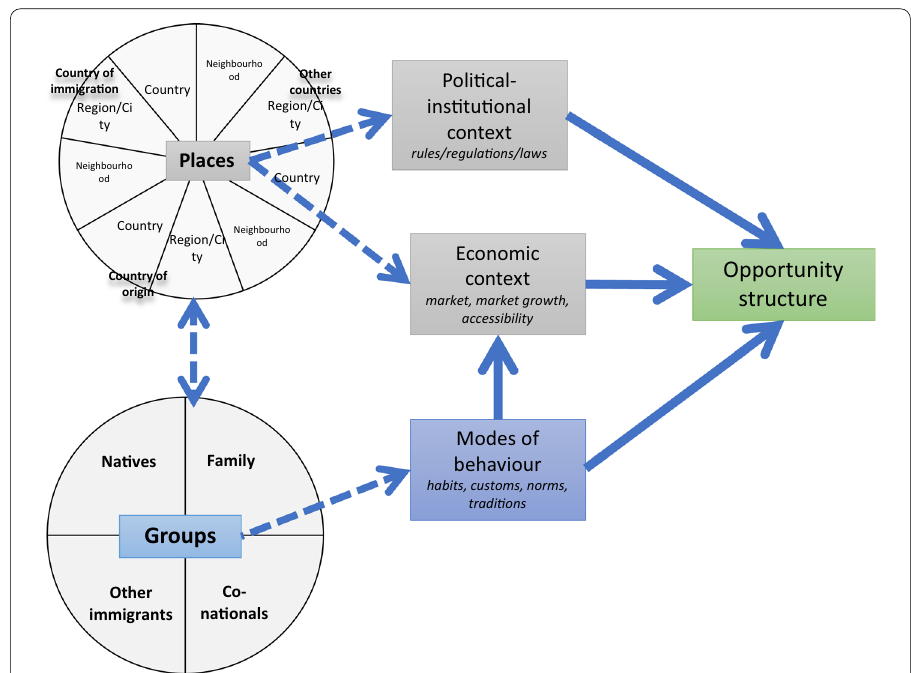
Fig. 2 A multifocal approach to mixed embeddedness—the opportunity